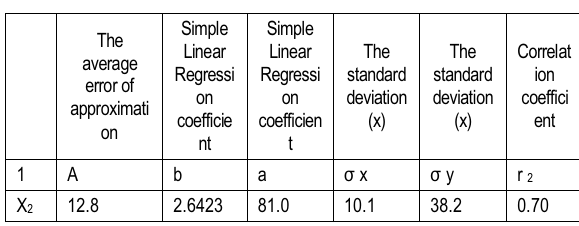
Table 5. Final estimates in terms of x